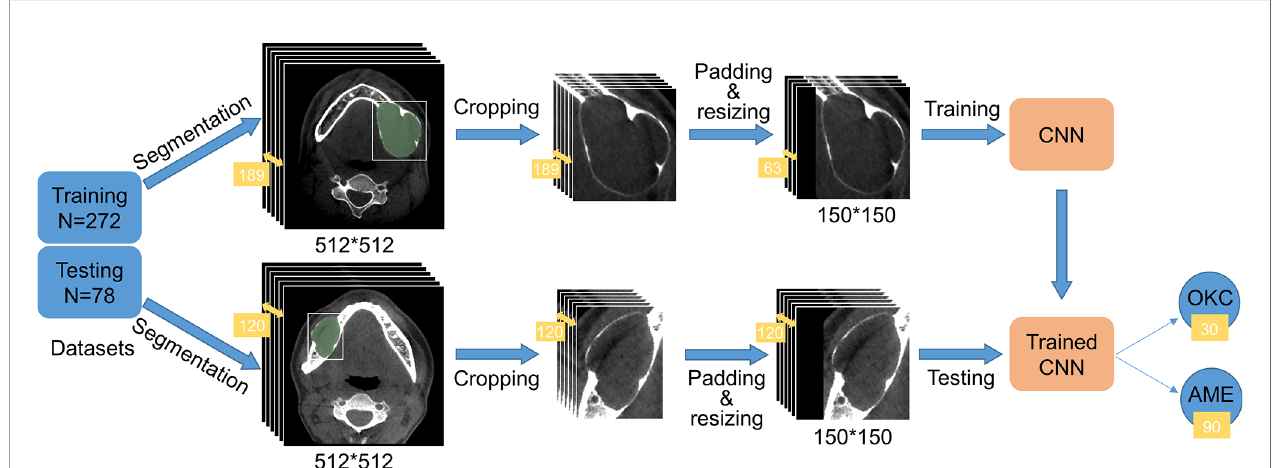
FIGURE 2 | Flow diagram of the study. The training and testing datasets contained 272 and 78 patients, respectively. A total of 189 images comprising the region of interest (ROI) of one patient in the training dataset were cropped into smaller rectangles, padded into square images using black, and resized to 150 * 150 to gear the CNN. To reduce redundancy, we selected one image out of every three images. The series in the testing dataset underwent the same process except for changing the number of images. As shown in the picture, 120 slices of AME patient were tested by the trained CNN. Ninety slices were predicted to have AME and 30 slices were predicted to have OKC, so AME was ultimately